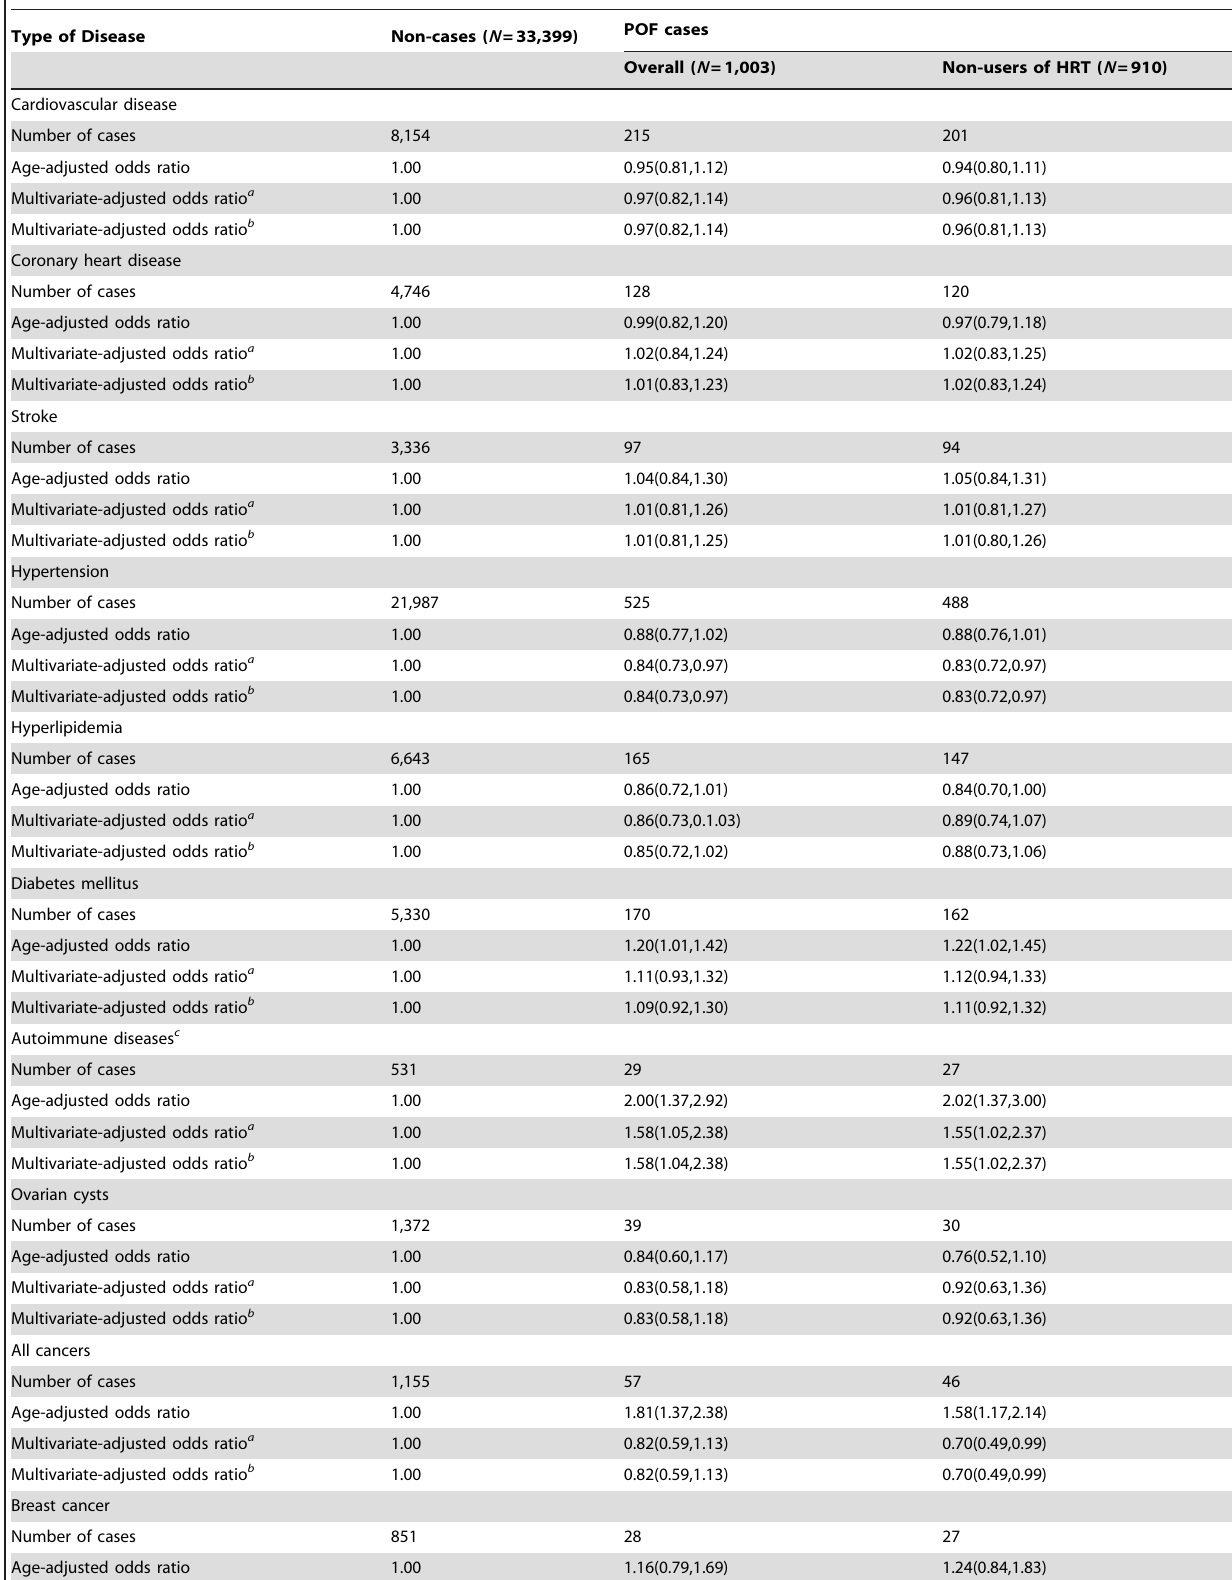
Table 4. Adjusted ORs and 95%CIs for chronic disease morbidity in women with POF in the Shanghai Women’s Health Study.